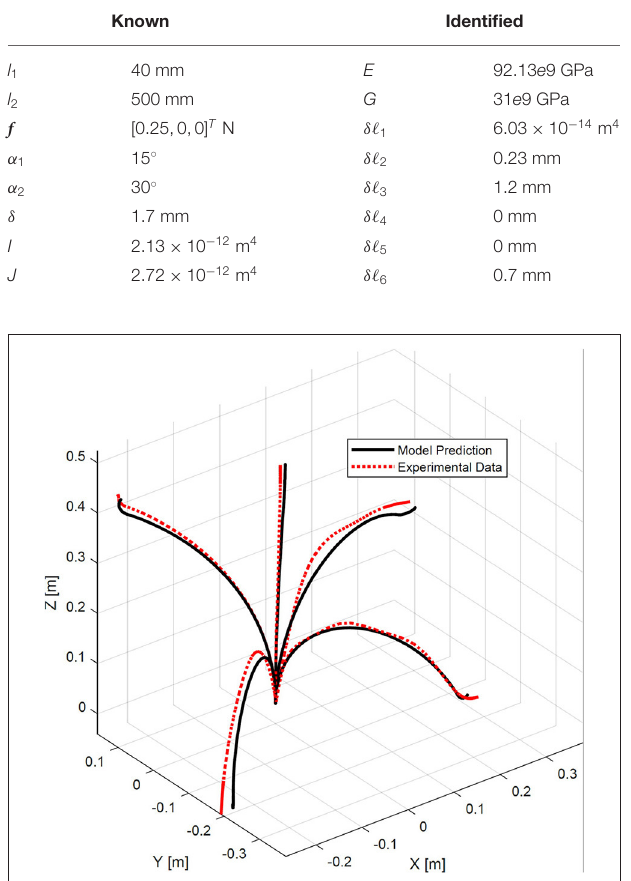
FIGURE 6 | A comparison of experimental bronchoscope’s shape with model prediction at four different configurations.